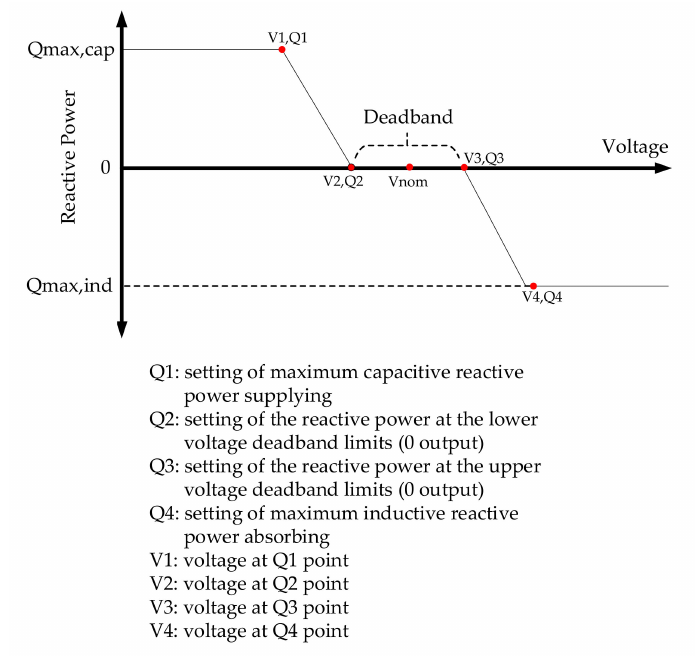
Figure 6. PV inverter voltage / var